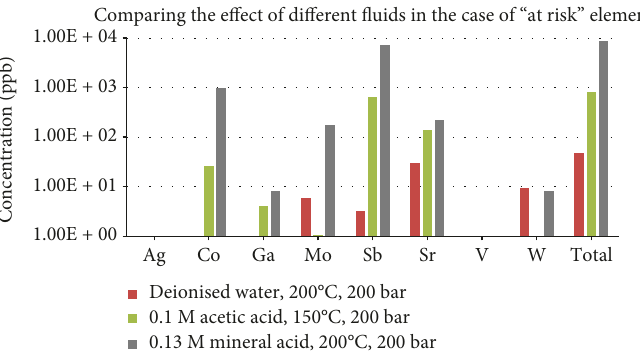
Figure 18: Comparison of the e ff ectiveness of di ff erent fl uids for “ at risk ” elements with concentrations in ppb.